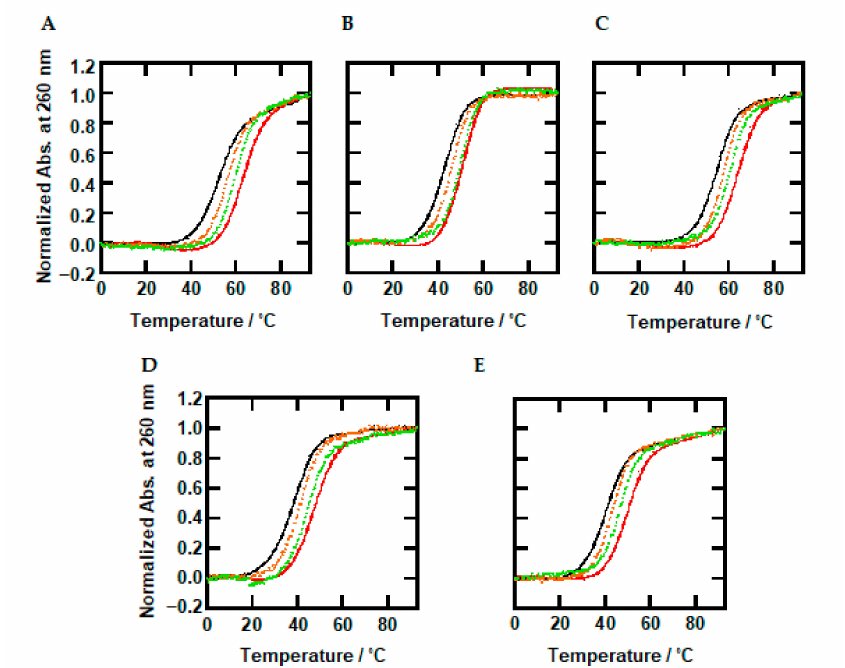
Figure 3. Normalized UV-melting curves for 2.0 µ M Me0, Me3, Me5, and Me8. Normalized UV-melting curves in the 100 mM KCl buffer in the absence of cosolutes ( A ) or in the presence of 30 wt% PEG200 ( B ), TMAO ( C ), urea ( D ), or L-proline ( E ). UV melting curves were traced at 260 nm. Me0: black, Me3: orange, Me5: green, and Me8: